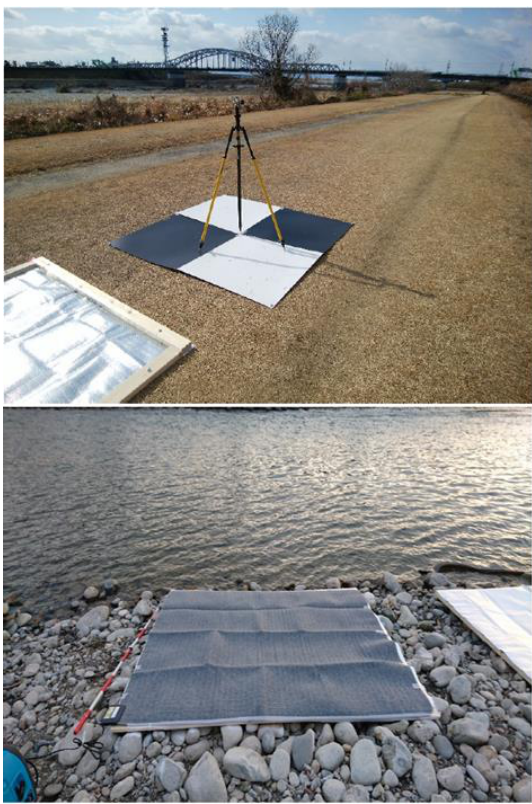
Figure 1. Left: Ground marker for ultrasensitive camera (air photo signal). Right: Ground marker for thermal infrared